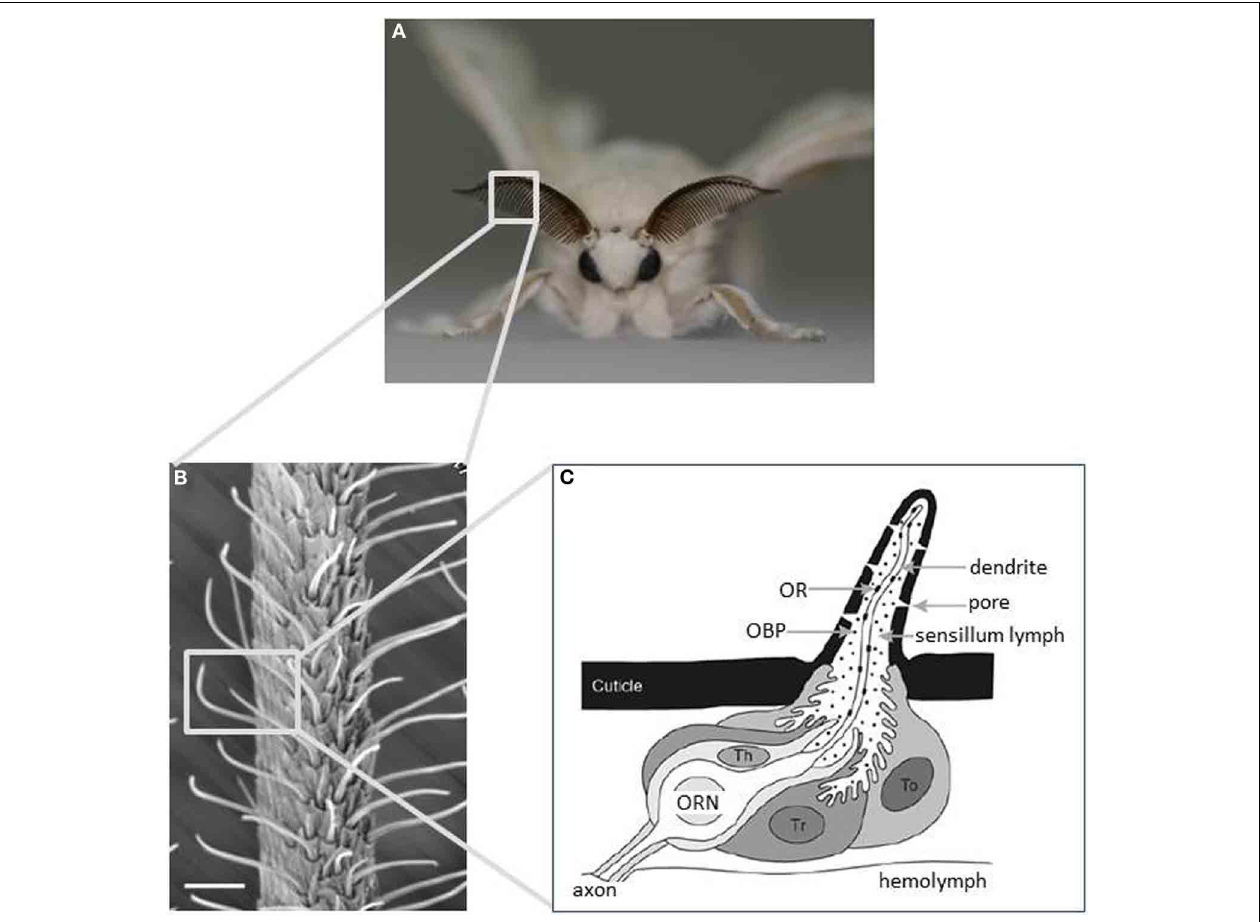
FIGURE 1 | Main olfactory sensory organs of the silkmoth Bombyx mori . (A) A male silkmoth with its prominent antennae optimized for odorant detection. (B) Scanning electron micrograph of an antenna displaying the external morphology of sensilla trichodea. Scale bar: 25 μ m. (C) Schematic diagram of an olfactory sensillum showing the detailed configuration of ORNs